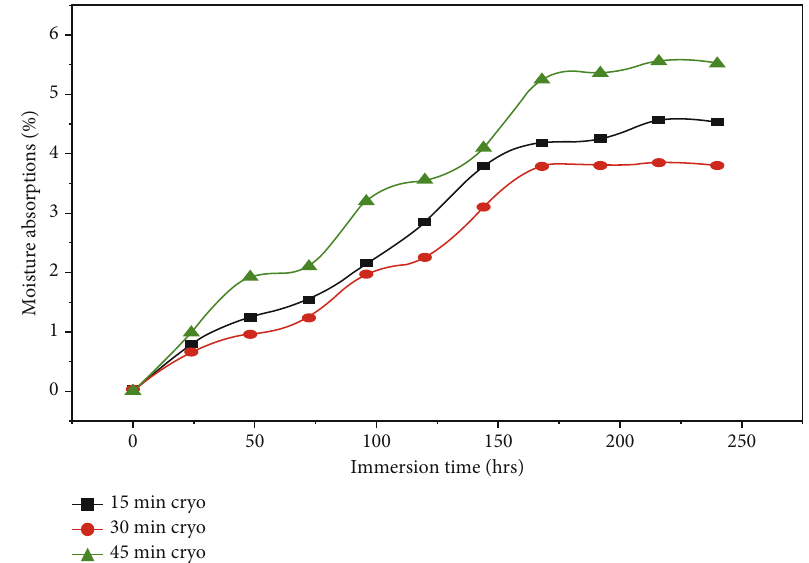
Figure 10: Moisture absorption characteristics of nanocomposite based on cryogenic treatment.